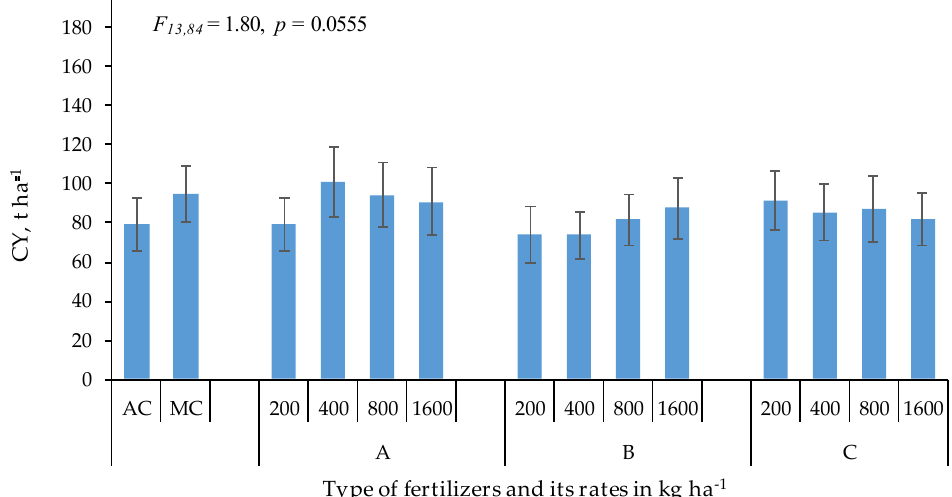
Figure 2. Effect of bio-fertilizer application on commercial yield (CY) of tomato (mean for 2016–2018). Hatched bars represent 2 × standard error ( SE ) ranges. Key: A, B and C—bio-fertilizers; AC— absolute control; MC—mineral control.